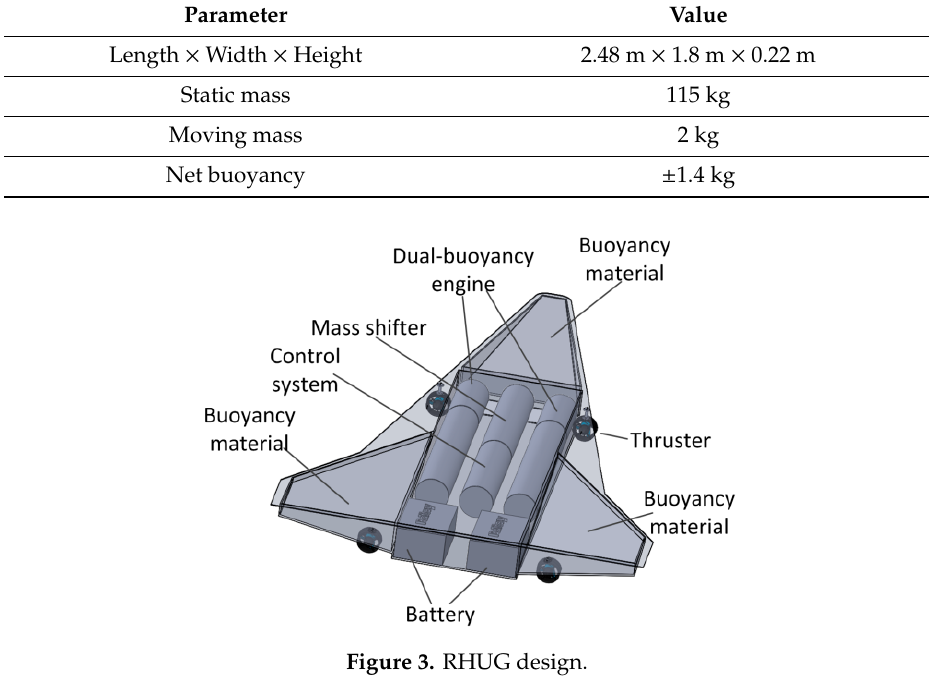
Figure 3. RHUG design.